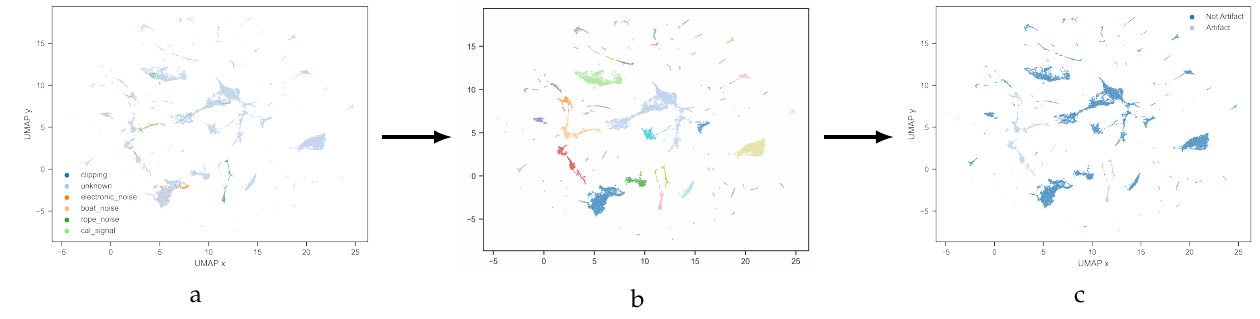
Figure 4. ( a ) distribution of the labeled artifacts on the 2D UMAP dimension; ( b ) obtained 37 clusters after applying DBSCAN; ( c ) data considered to be artifact.